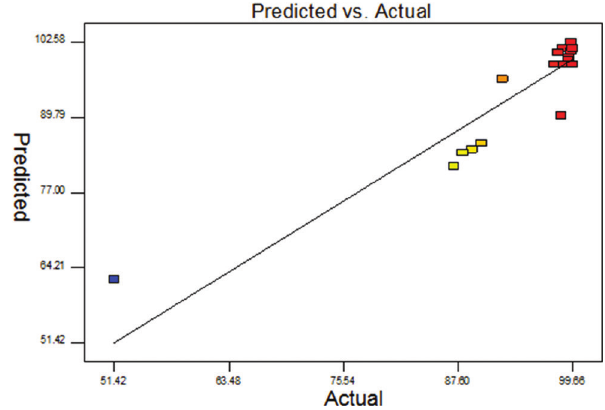
Figure 1: Predicted response vs. actual response.